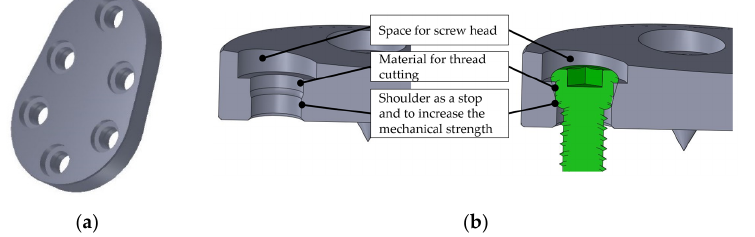
Figure 2. Result of detailed design of rigid variant: ( a ) three-dimensional view; ( b ) sectional view.